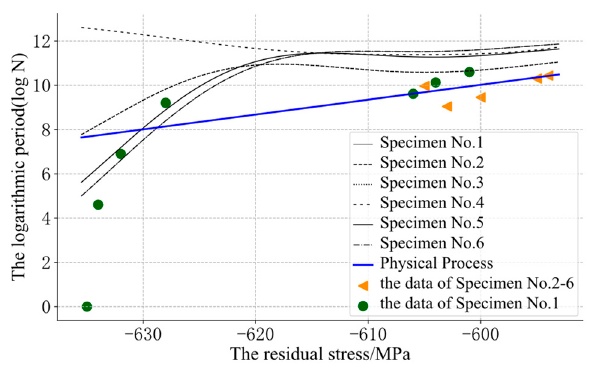
Figure 5. The assessment results of the GP.